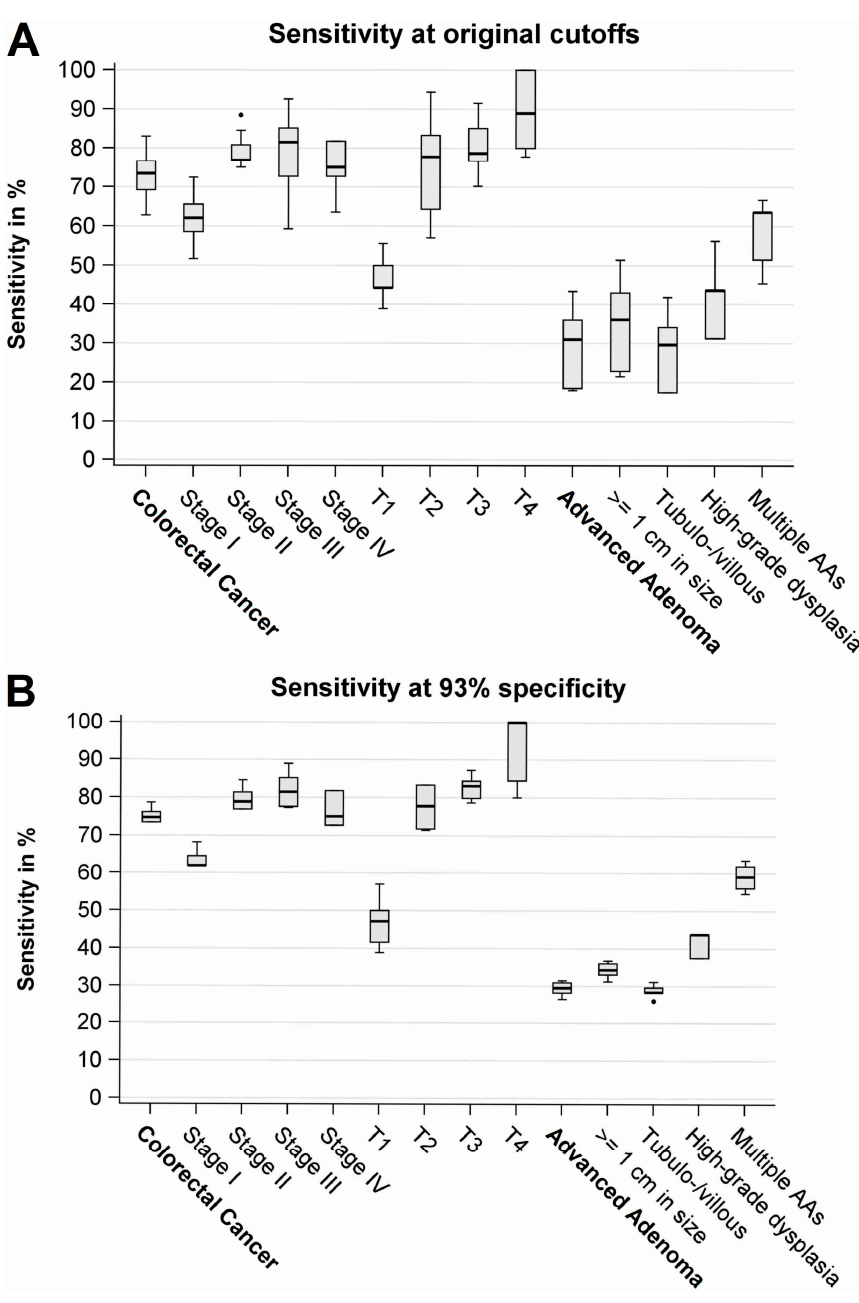
Figure 2. Box plots of sensitivities at original cutoffs ( A ) and at adjusted cutoffs ( B ) across the FITs. AA, Advanced adenoma.